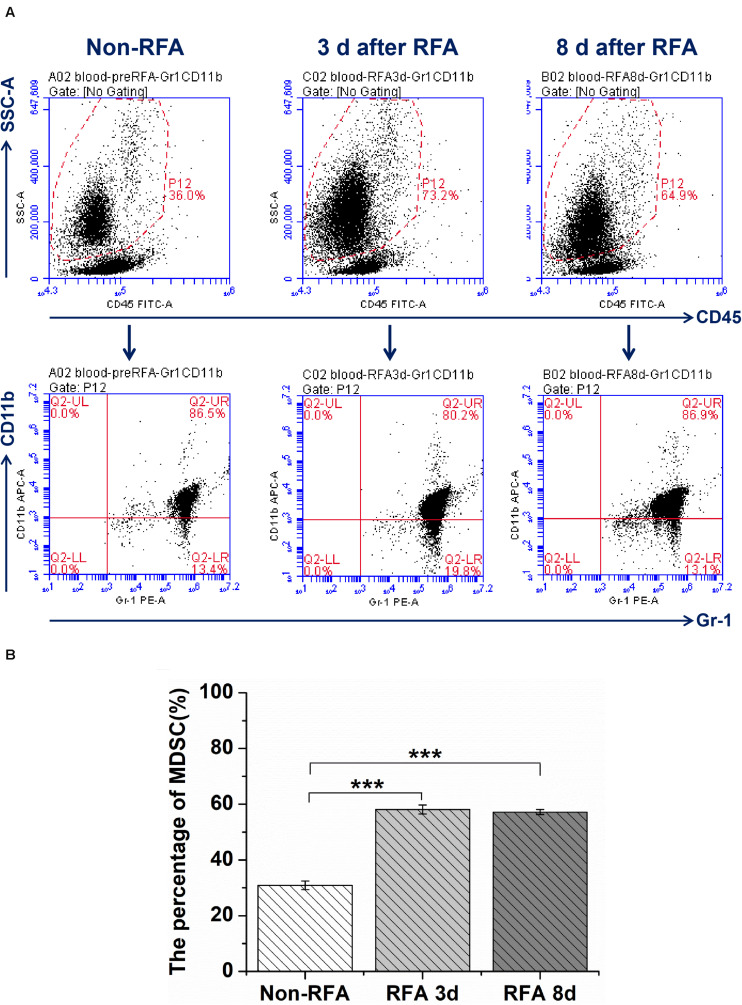
The flow cytometry analysis for MDSCs was performed through whole blood cells from mice bearing tumor treated with different treatment groups at different time points (Non-RFA, 3 days after RFA, 8 days after RFA). (A) the representative images from one experiment show a shift in the MDSCs population by flow cytometry analysis. (B) The percentage of MDSCs from different treatment groups at different time points, ***P < 0.001, **P < 0.01.